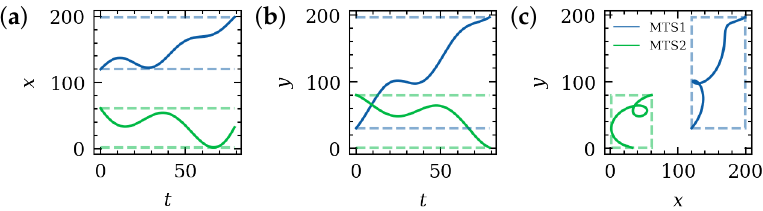
Figure 3. Similarity between two-dimensional time series by the MBR of the corresponding spatial objects in the two-dimensional space. ( a ) Minimum/maximum value of time series in dimension x ; ( b ) Minimum/maximum value of time series in dimension y ; ( c ) MBRs of the corresponding spatial